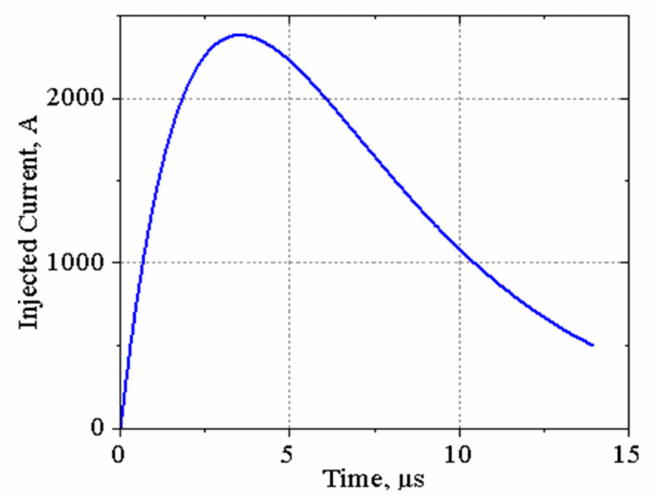
Figure 14. Injected current to the vertical rod of 1.5 m.